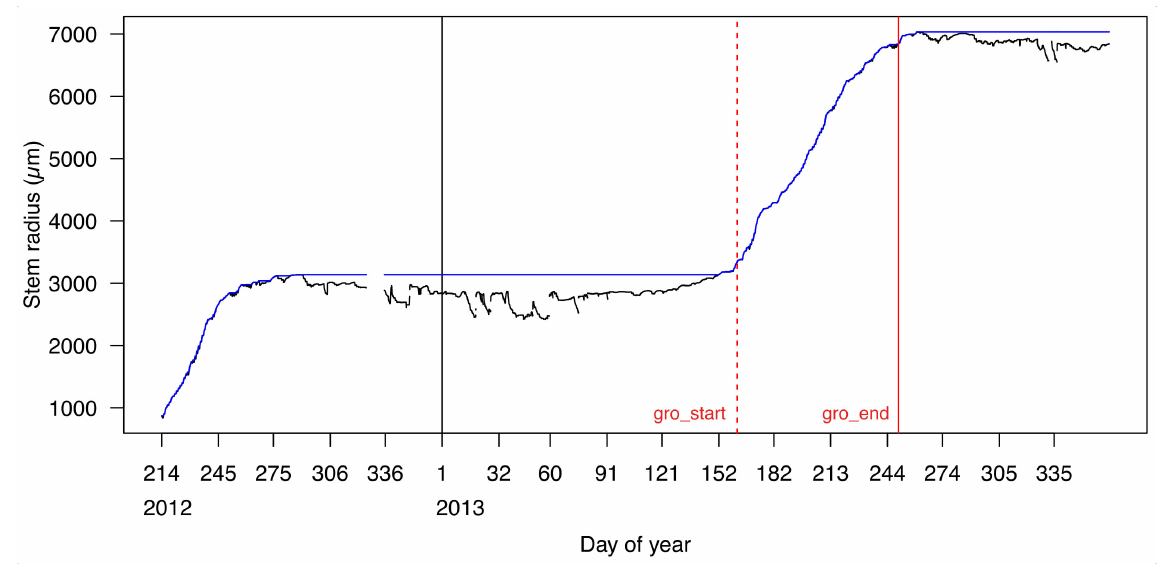
Figure 4. Calculation of start ( gro_start , red dashed line) and cessation ( gro_end , red solid line) of the growing season by the function grow_seas with a 5% uncertainty tolerance ( tol_seas =